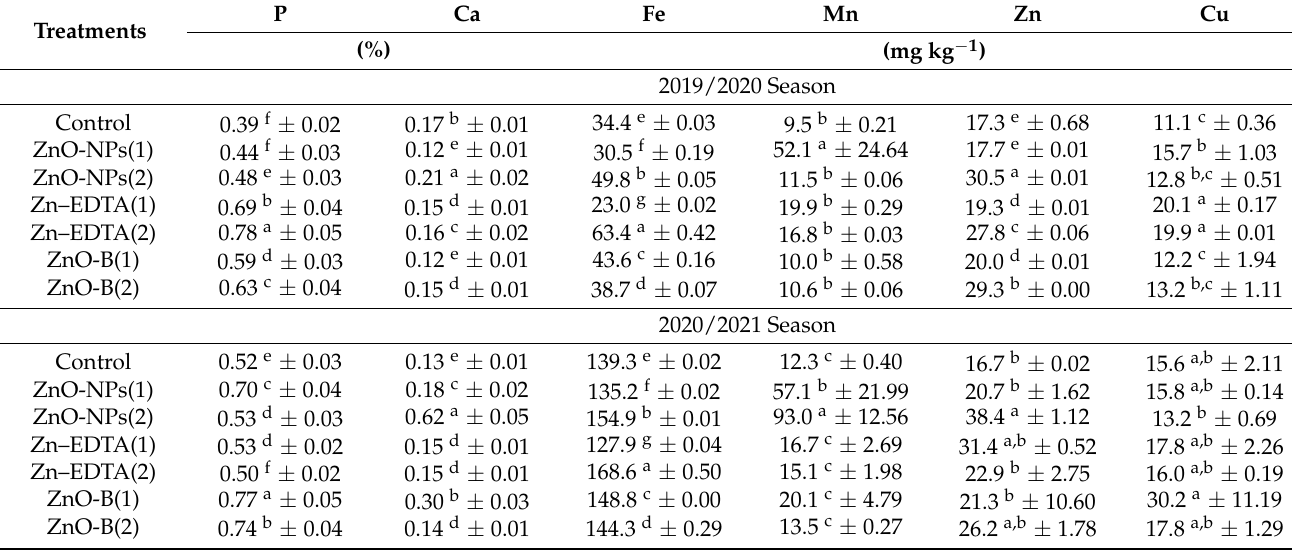
Table 6. Influence of foliar nourishment with some zinc (Zn) forms on root nutrient contents of carrot plants grown under Zn deficiency stress in two growth seasons.